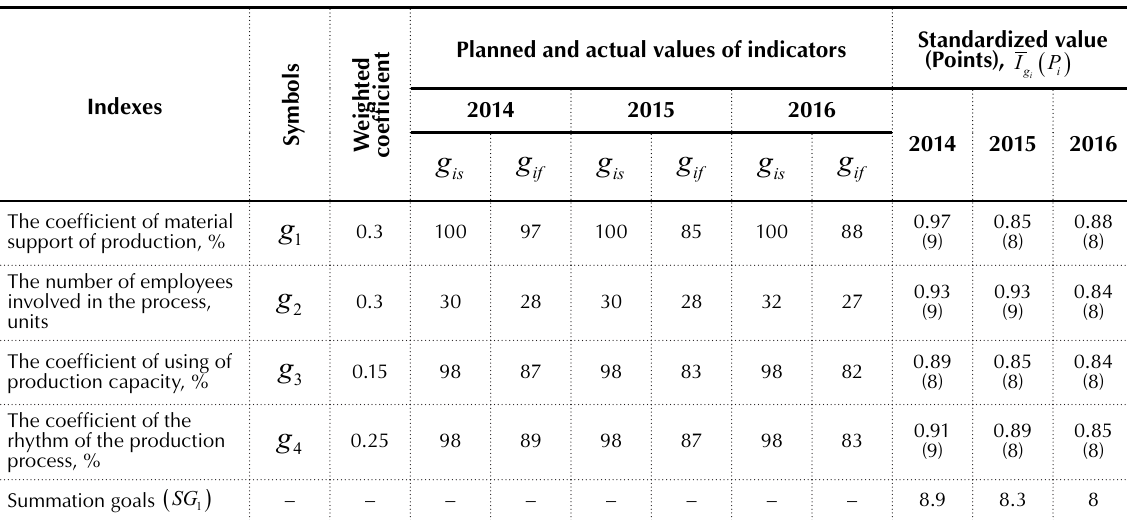
Table 2. Indicators of strategic control of the business process “production of boards” of Numinator Ltd.